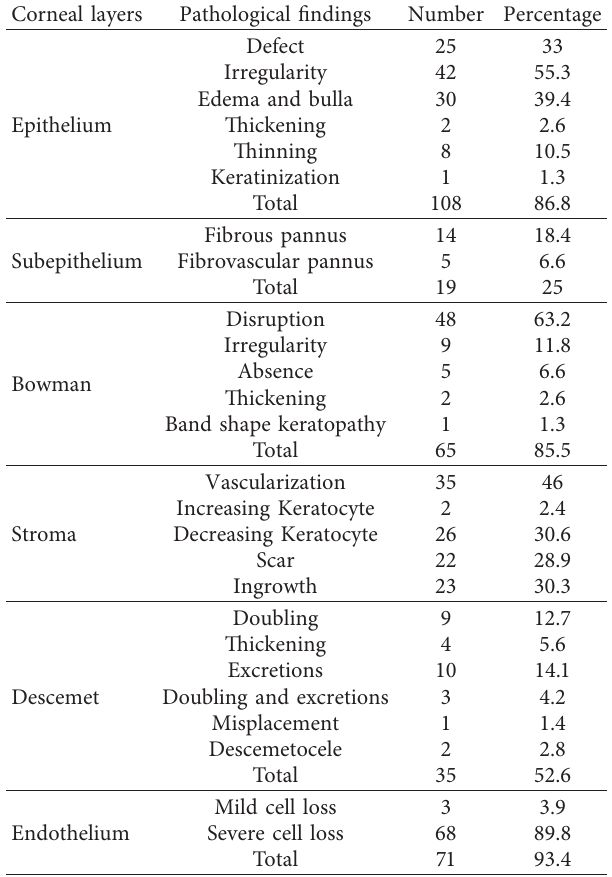
Table 3: Histopathological findings of corneal regrafts. Corneal layers